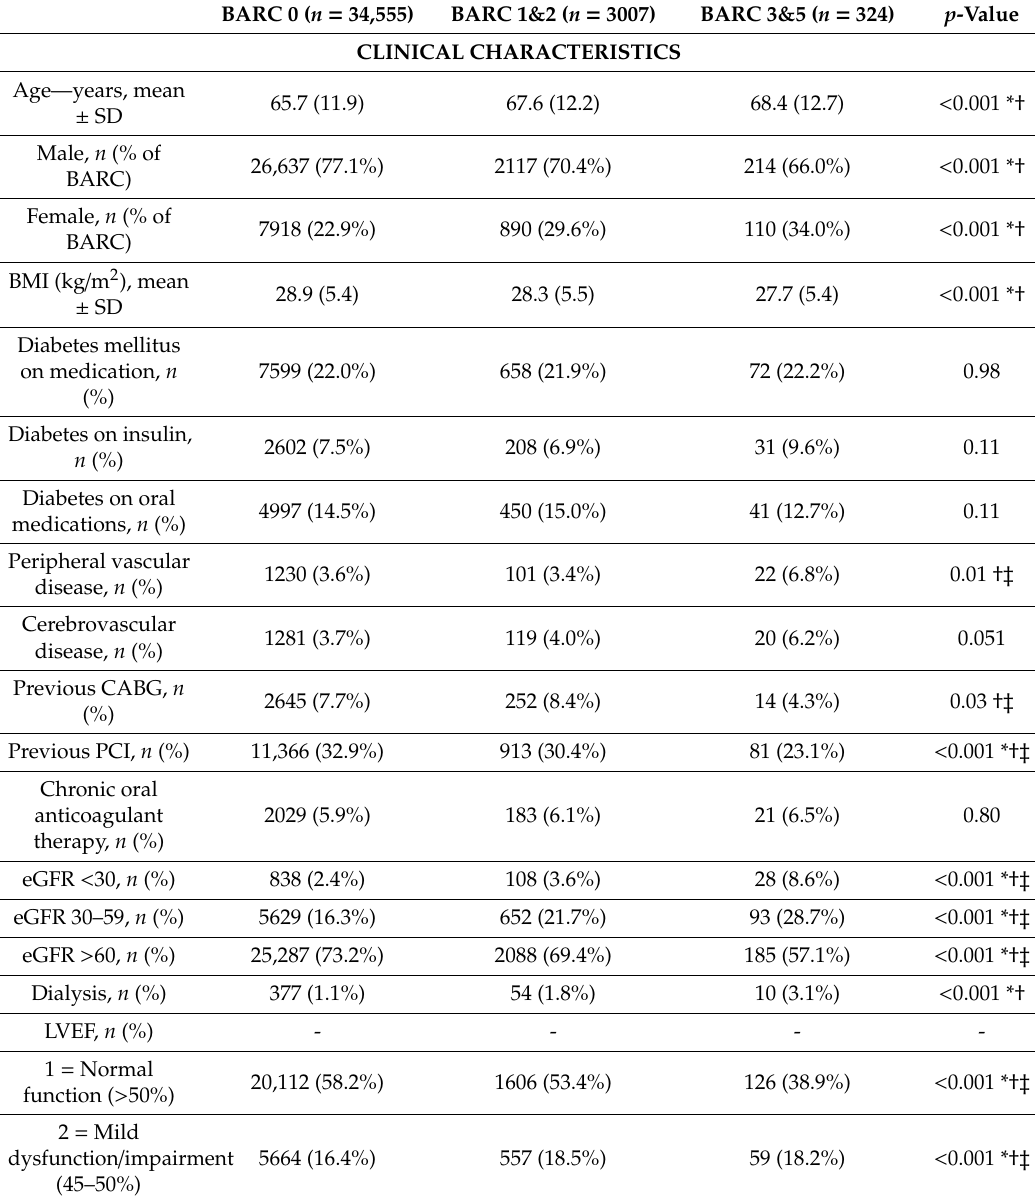
Table 1. Baseline clinical